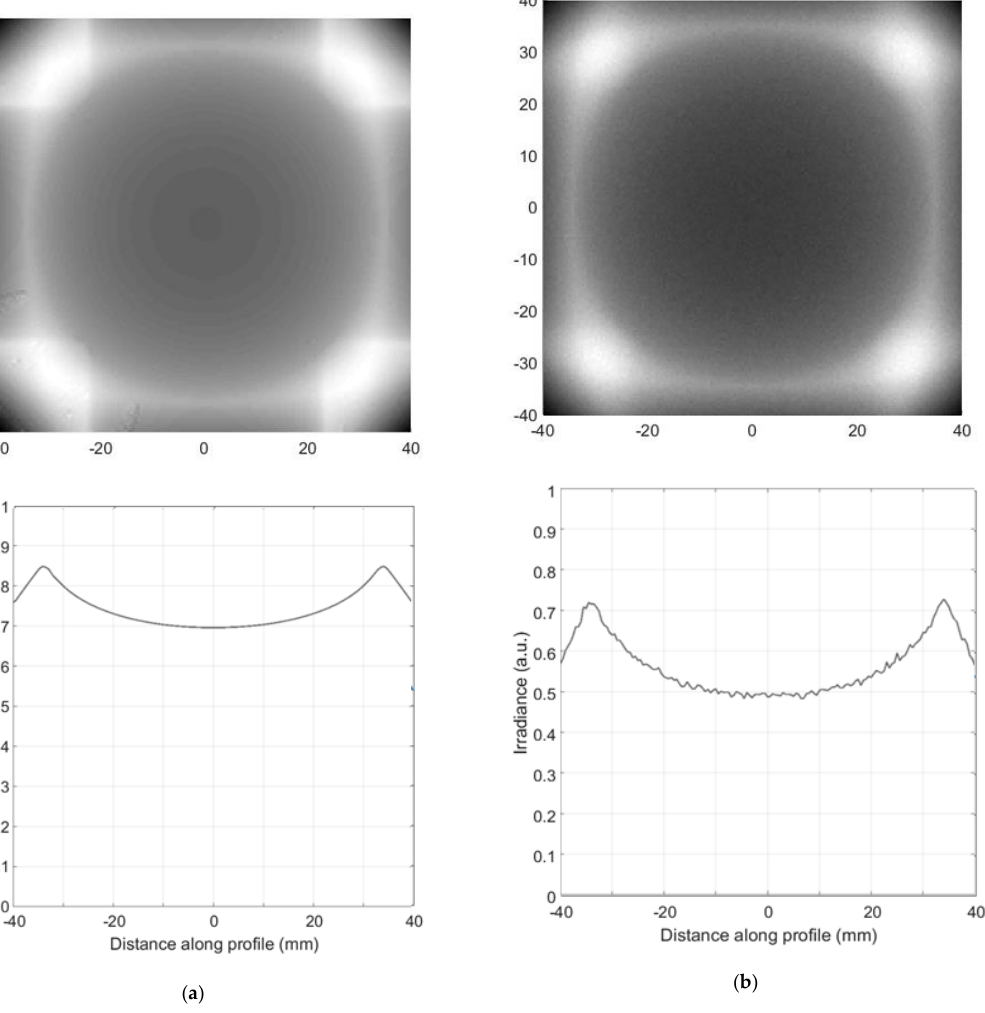
Figure 6. Irradiance pattern and central irradiance profile at the detector: ( a ) computed by flowline vector potential method; ( b ) computed by raytrace.